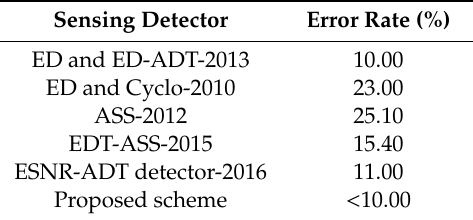
Table 3. Comparison of detectors according to their error rates.